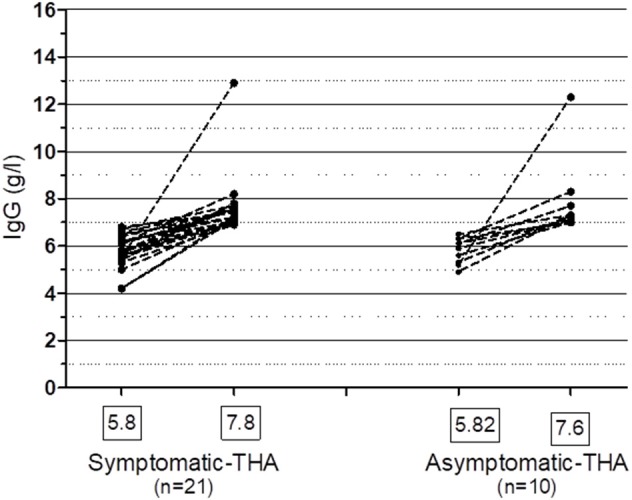
Spontaneous recovery of IgG ≥ 7.0 g/l in patients with symptomatic and asymptomatic hypogammaglobulinemia on at least one occasion. One patient who was treated with IVIG, who recovered her IgG is included in the Symptomatic group. THA, transient hypogammaglobulinemia of adulthood. Mean IgG levels (g/l) are shown in the boxes.